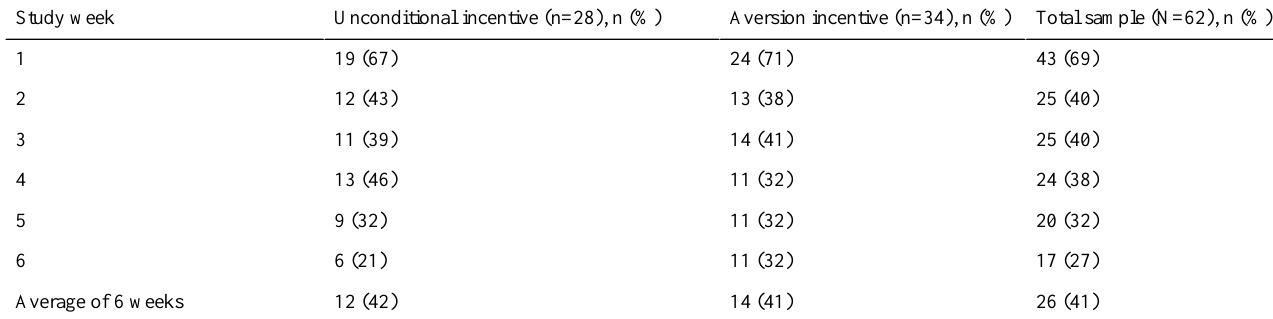
Table 5. Response rate to the intervention activities by week by the treatment